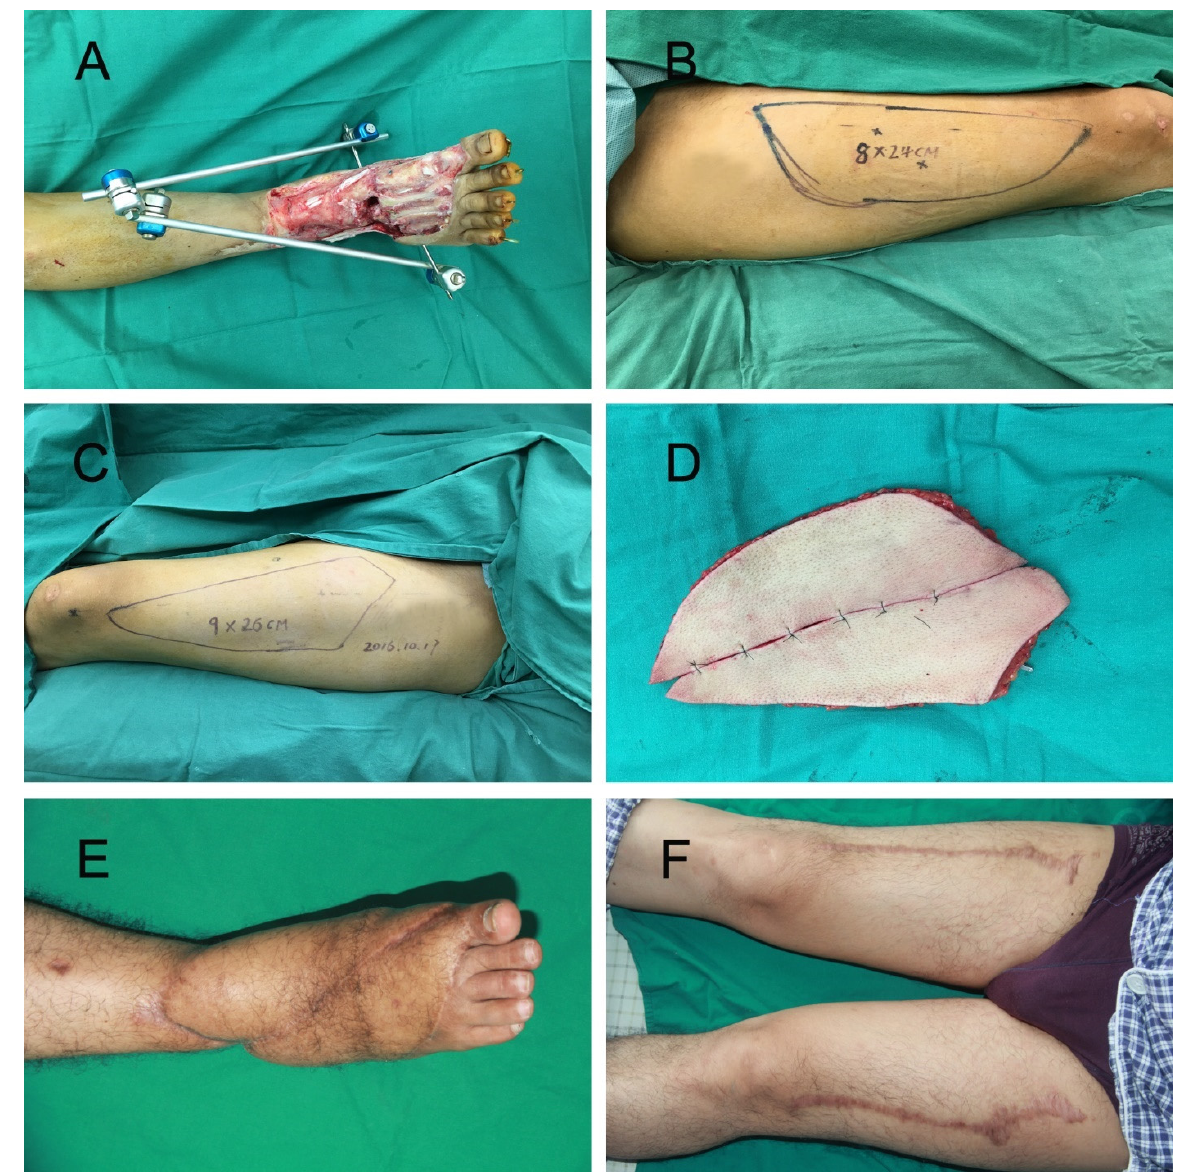
Figure 1. ( A ) A 30-year old male sustained injuries to the right ankle and foot in a traffic accident. Radical debridement left a large wound on the right lower extremity. ( B ) Right ALT flap with 24 × 8 cm 2 was designed. ( C ) Left ALT flap with 26 × 9 cm 2 was designed. ( D ) Chain-linked bilateral ALT flaps were harvested. ( E , F ) Recipient and donor site at the 12-month follow-up.